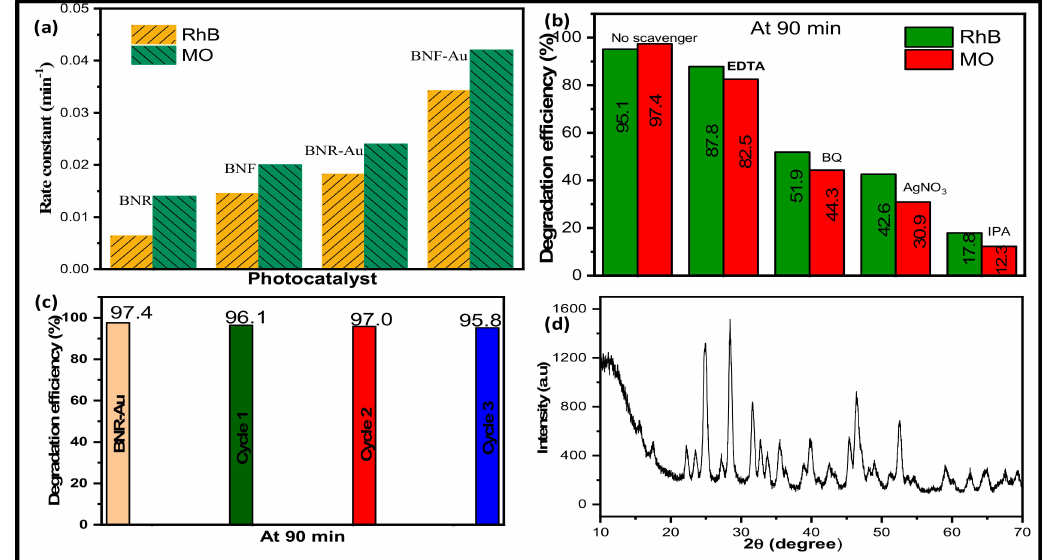
Figure 5. ( a ) Comparison of rate constants of the Bi 2 S 3 nanocrystals and their gold-decorated analogues, ( b ) the effect of different active species-trapping experiments on degradation using BNF-Au as a representative, ( c ) percent degradation efficiency with increasing number of catalytic cycles at irradiation time of 90 min, and ( d ) XRD pattern of BNF after three catalytic